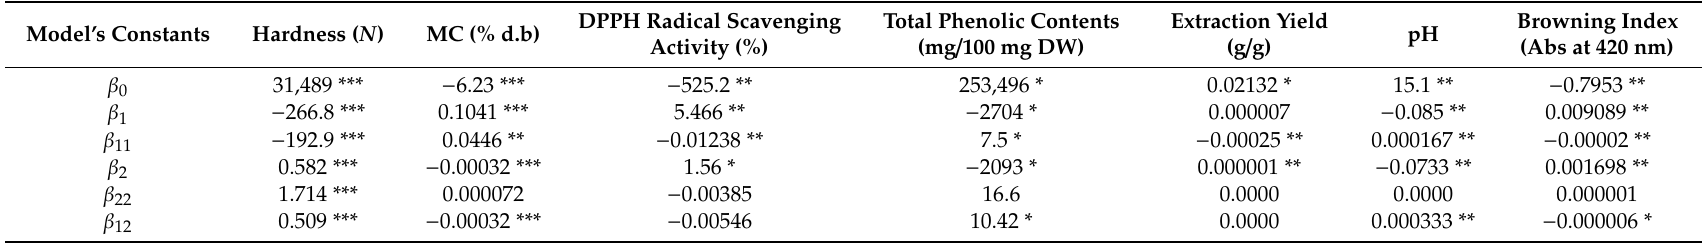
Table 4. Regression coe ffi cients of the second order polynomial model for physical, antioxidative and quality properties of the whole date seeds, powder and brew. Model’s